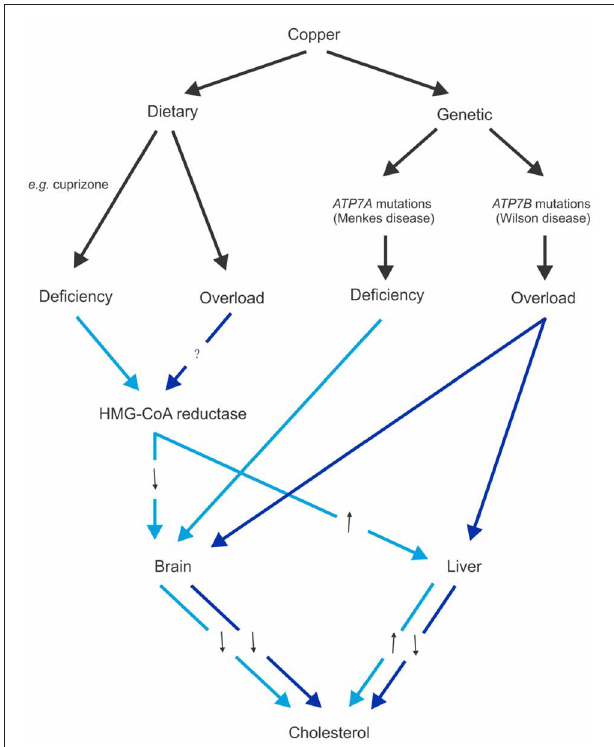
FIGURE 1 | Schematic diagram of the effects of dietary and genetic copper manipulation on cholesterol levels, based on availabledata from animal models. Light blue and dark blue arrows represent pathways associated with copper deficiency and overload conditions, respectively. Black arrows denote either increased ( ↑ ) or decreased ( ↓ ) 3-hydroxy-3-methylglutaryl-coenzymeA (HMG-CoA) reductase expression or cholesterol levels as a consequence of altered copper